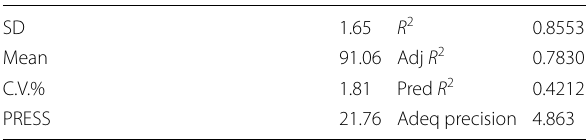
Percentage removal of nickel (Ni) using groundnut shell (GS) ANOVA for selected factorial model The Model F value of 11.82 implies there is a 7.52% chance that a "Model F value" this large could occur due to noise.